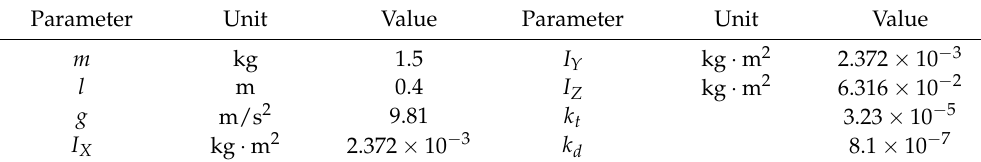
Table 2. Aircraft